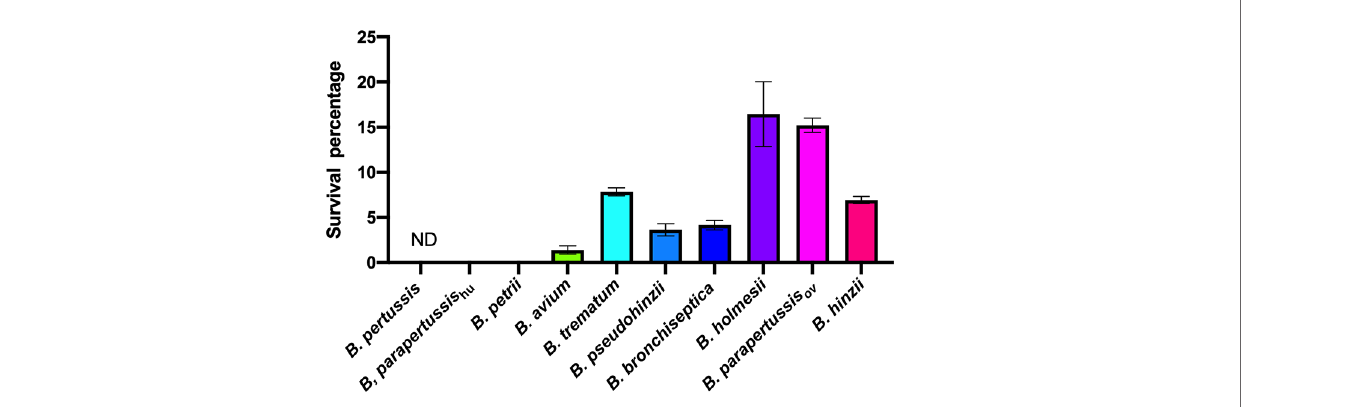
FIGURE 9 | Different intracellular survival rates of non-classical Bordetella species in RAW 264.7 murine macrophages. Intracellular survival of Bordetella species inside murine RAW macrophages was assessed in a 2-hour gentamicin protection assay at an MOI of 1. There were 3 replicates in each group. Error bars show the standard error of mean. ND,